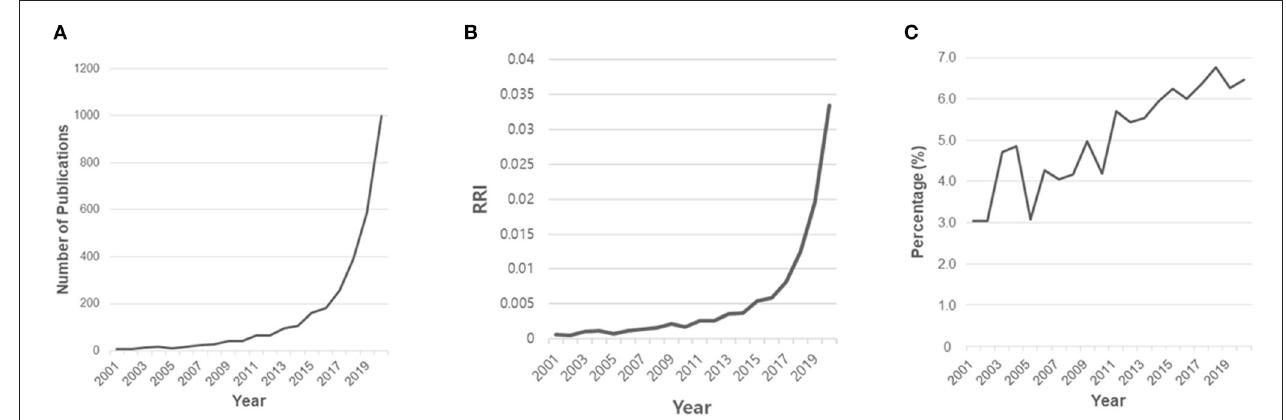
FIGURE 2 | Annual growth of gender-related publications in medical AI. (A) The number of publications by year. (B) Relative research interest by year. (C) The percentage of gender-related publications in medical AI.